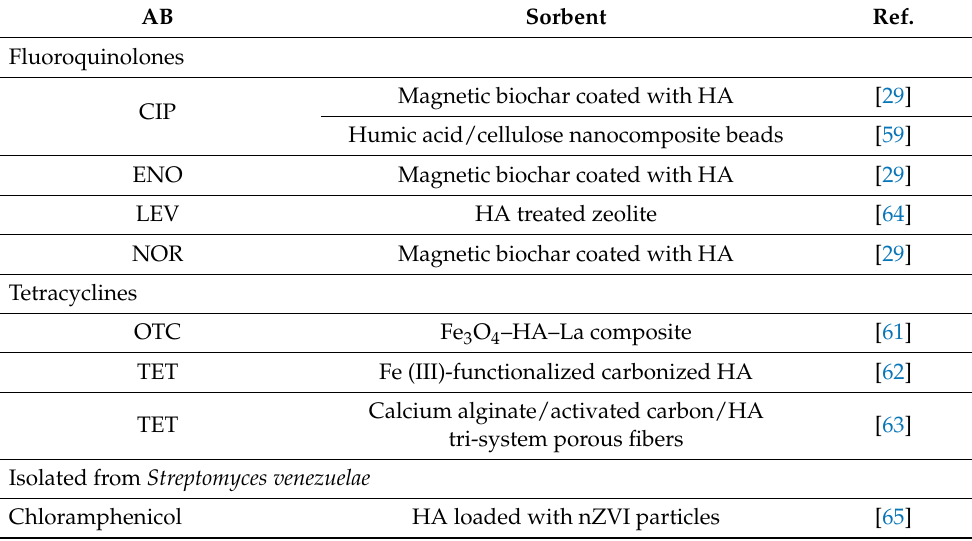
Table 6. Humic-based sorbents for